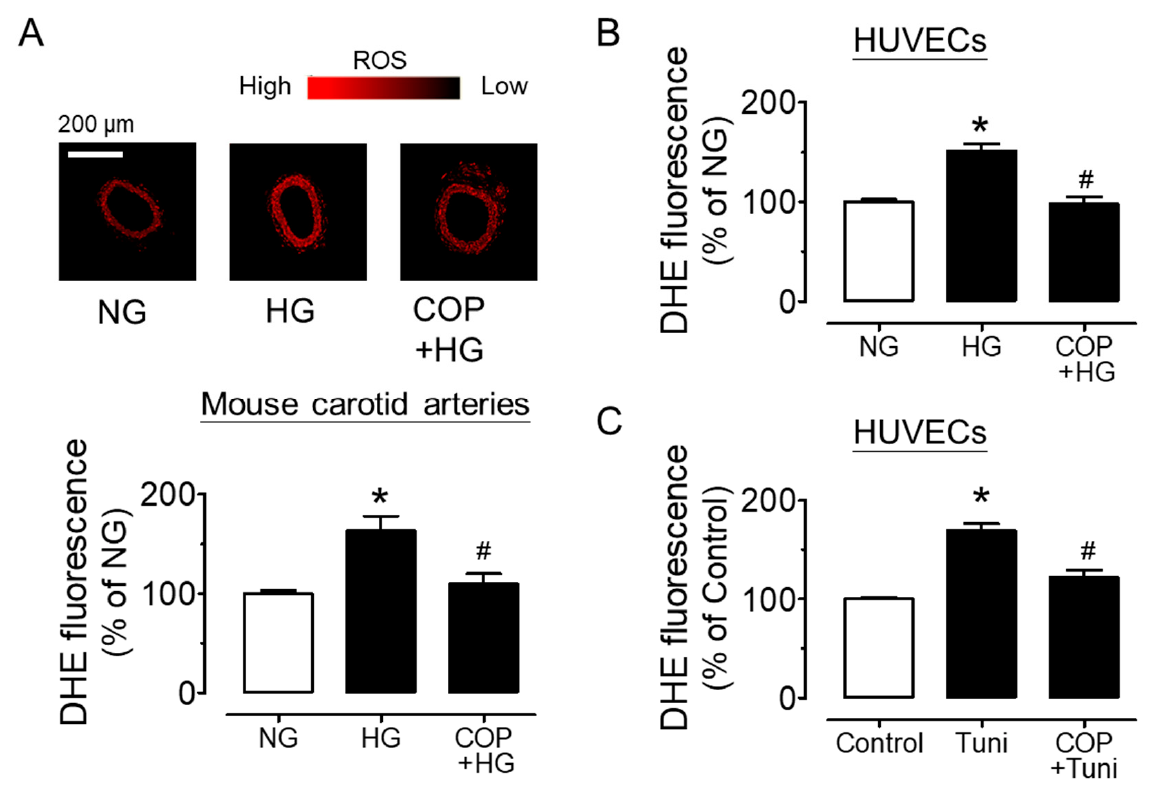
Figure 6. Coptisine (COP) reduces oxidative stress. Exposure to high glucose (30 mM, 4h) increased the level of reactive oxygen species (ROS) in ( A ) mouse carotid arteries and ( B ) HUVECs, and such elevation was decreased by COP at 1 µ M, as measured by dihydroethidium (DHE) staining. ( C ) COP treatment (1 µ M) suppressed the tunicamycin (tuni; 2 µ g/mL, 1 h)-induced ROS generation in HUVECs. Results are the mean ± SEM of 4 experiments. * p < 0.05 vs. NG or Control; # p < 0.05 vs. HG or Tuni.